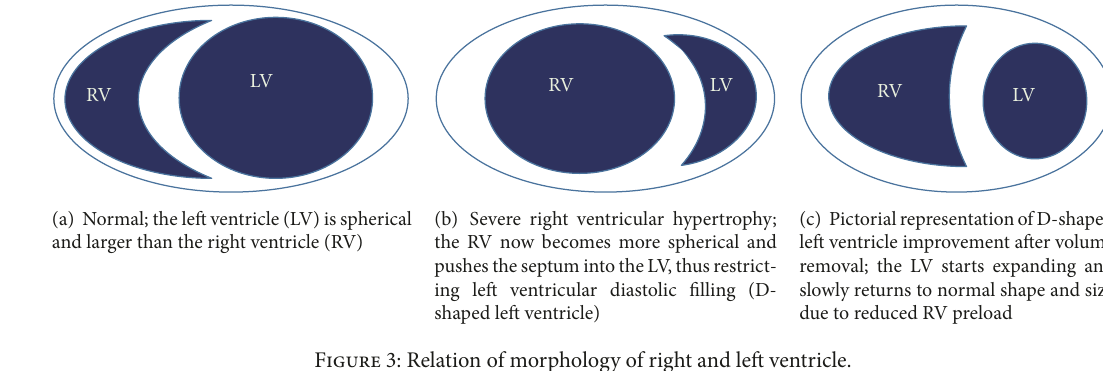
Figure 3: Relation of morphology of right and left